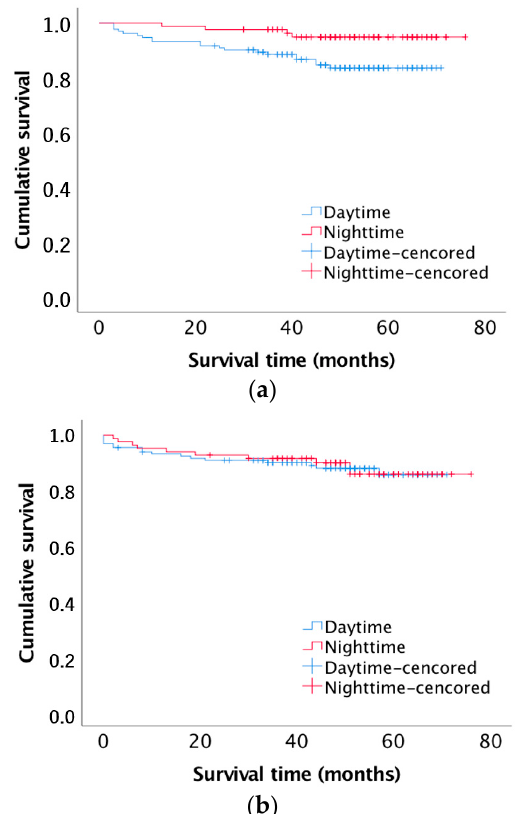
Figure 1. ( a ) Kaplan–Meier survival curve for patient survival after “day-time” and “night-time” renal transplantation (log-rank test 5.65; p = 0.017); ( b ) Kaplan–Meier survival curve for death censored Figure 1. a . Kaplan–Meier survival curve for patient survival after “day-time“ and “night-time“ renal graft survival of patients after “day-time” and “night-time” renal transplantation (log-rank test 0.014; transplantation (log-rank test 5.65; p = 0.017). b. Kaplan–Meier survival curve for death censored graft p = survival of patients after “day-time“ and “night-time“ renal transplantation (log-rank test 0.014; p = 0.907).